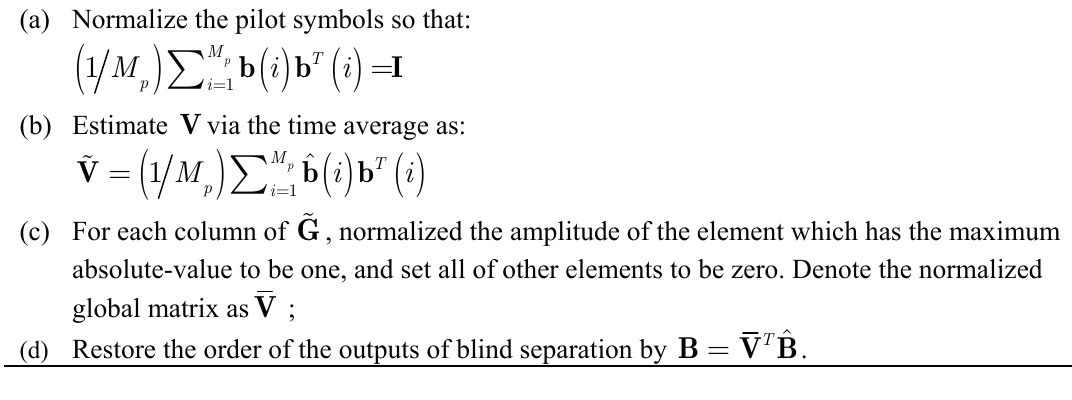
Table 1. Order ambiguity